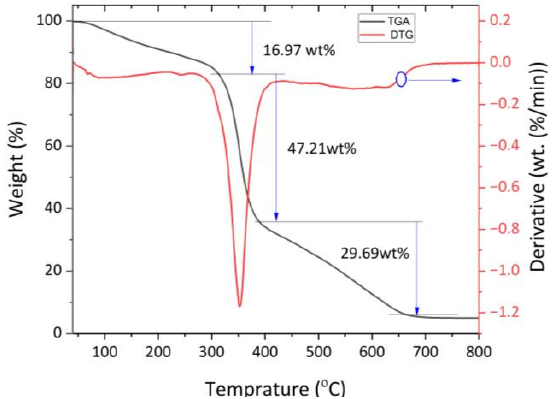
Figure 3. Thermogravimetric (TG) and derivative thermogravimetric (DTG) of teff husk.